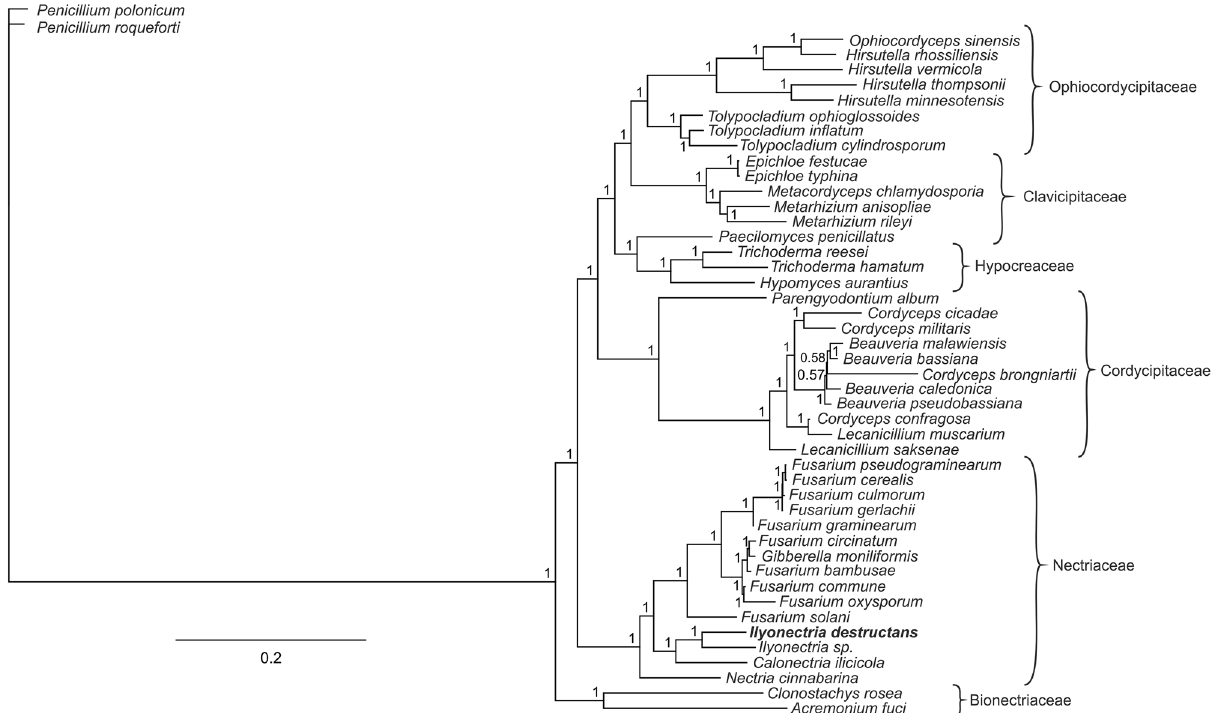
Figure 4. Phylogenetic tree based on sequences of sheared 15 protein-coding genes from 45 fungi species representing Hypocreales and two Penicillium species (outgroup) using Bayesian posterior probabilities (PP). Bayesian PP are given at each